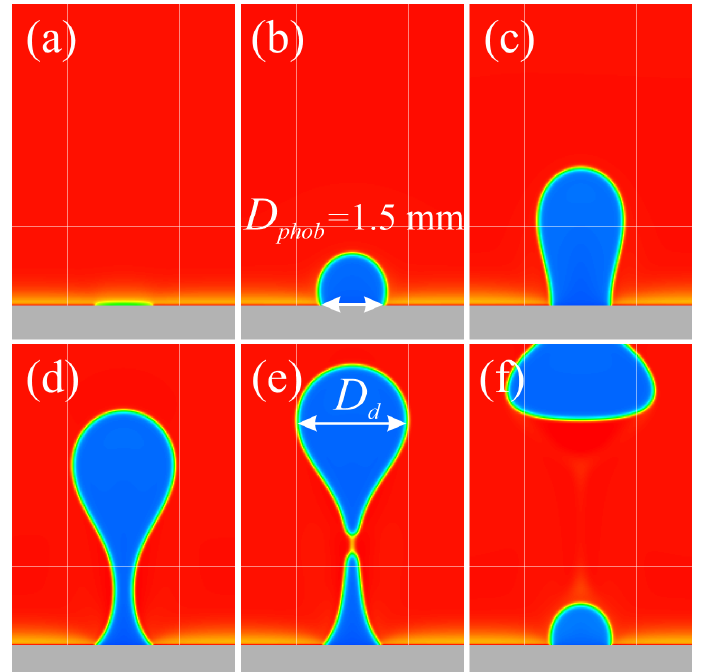
Figure 5. Temporal evolution of the growth and departure of a single bubble: ( a ) t = 0.15 s, ( b ) t = 0.175 s, ( c ) t = 0.375 s, ( d ) t = 0.475 s, ( e ) t = 0.5 s, ( f ) t = 0.525 s. Lyophobic zone size D phob = 1.5 mm, horizontal region size is 12 mm, heater temperature T h = 0.95 T c .